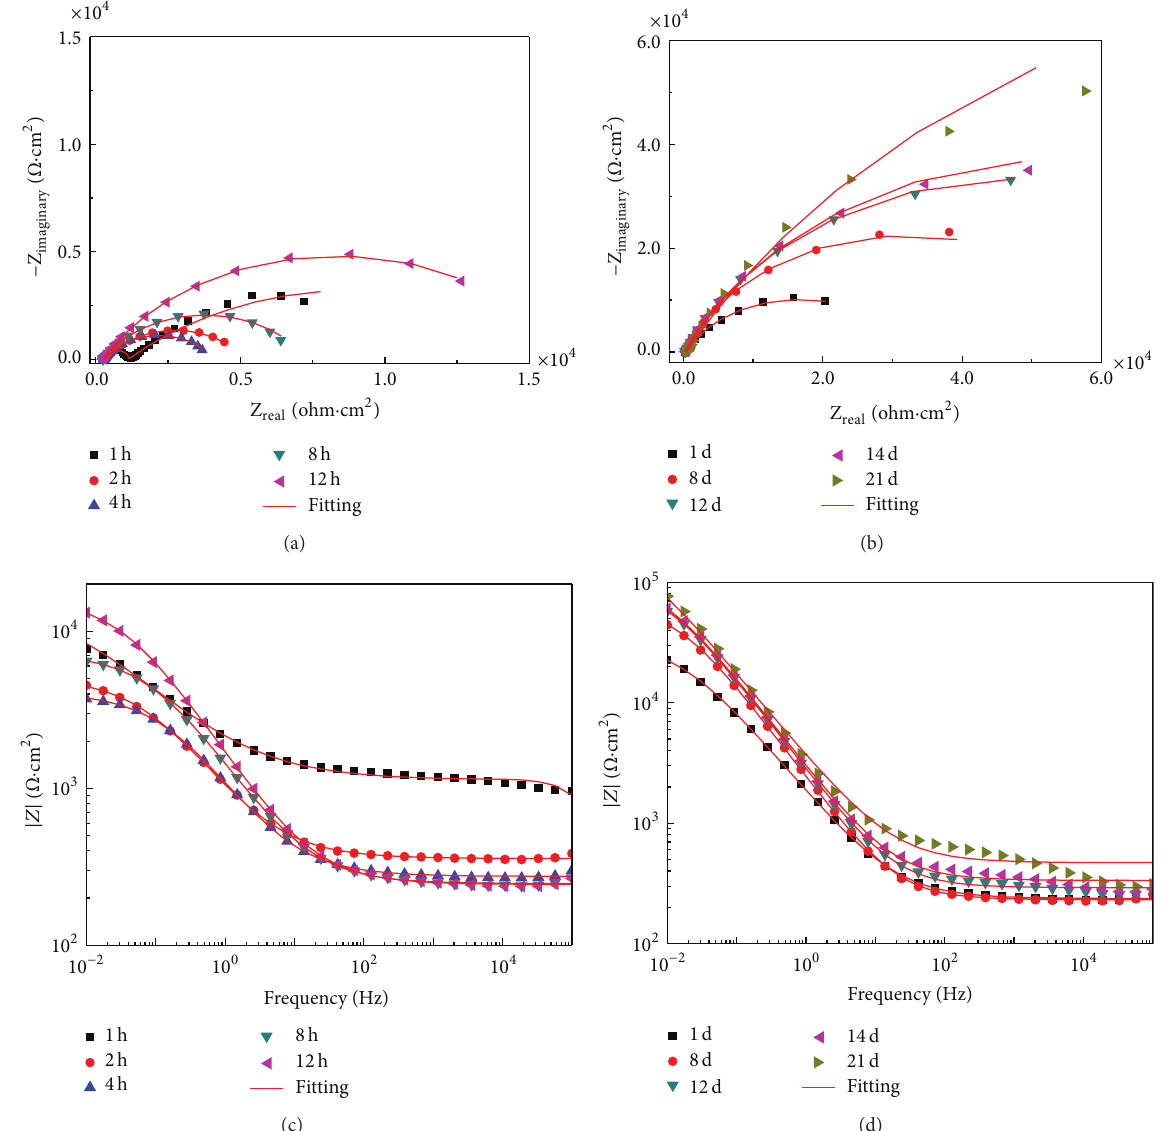
Figure 2: Impedance spectra of painted samples without scratch after different immersion time in 3.5 wt% NaCl solution: (a) Nyquist plots from 1h to 12 h, (b) Nyquist plots from 1d to 21d, (c) Bode plots from 1h to 12h, and (d) Bode plots from 1d to 21 d.